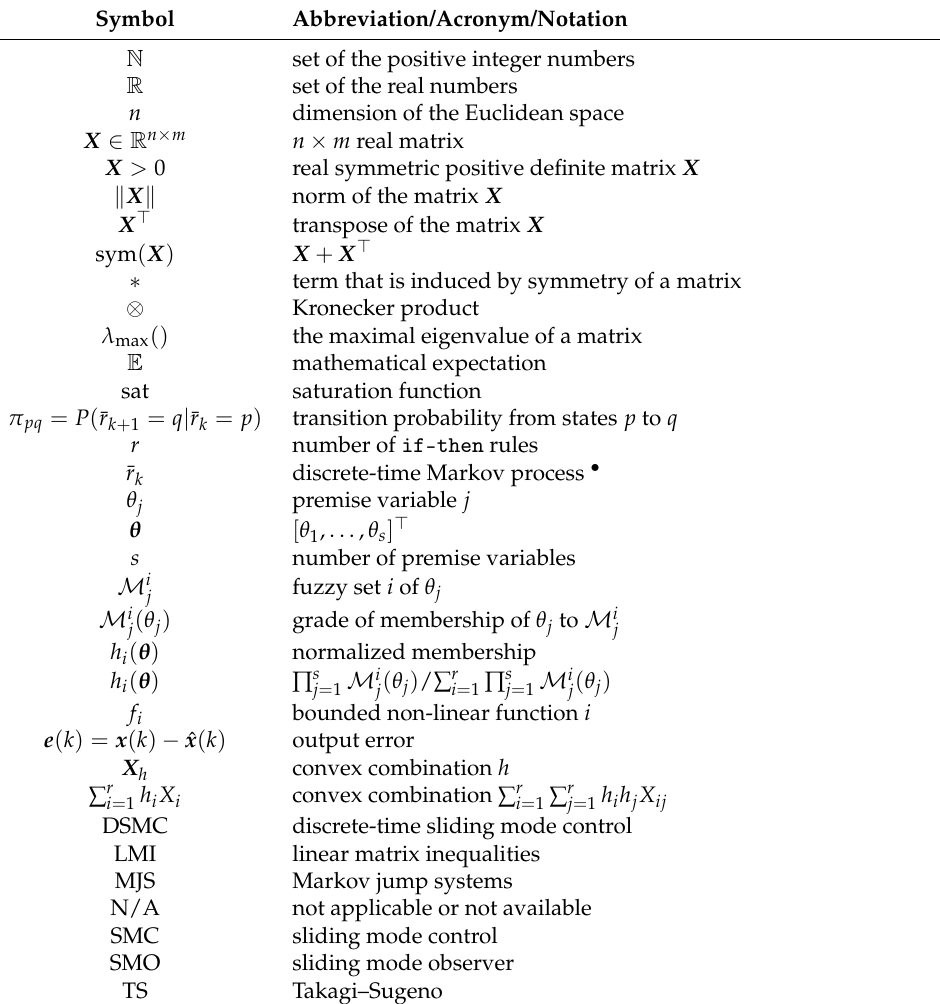
Table 1. Abbreviations, acronyms, and notations used in the present